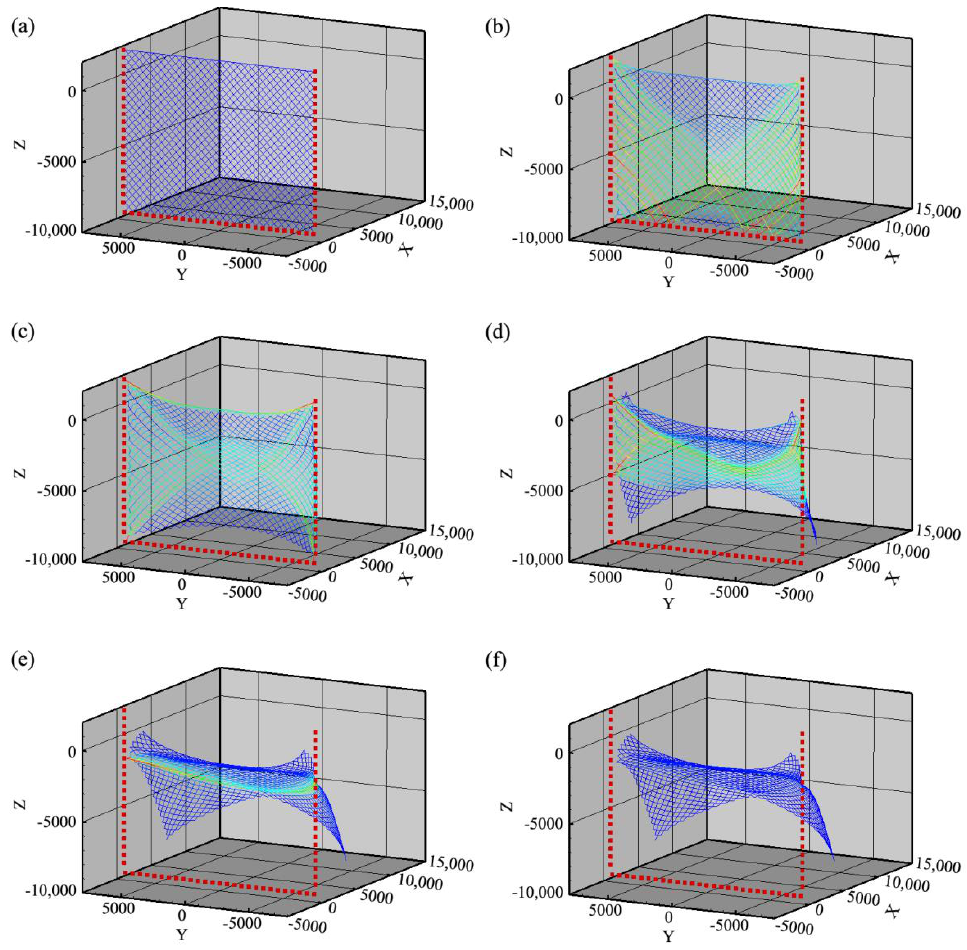
Figure 15. ( a – f ) Damage process of the mooring system for the trash-blocking nets when T m = 3.0 kN. When the strength of mooring lines ( T m ) is 3.0 kN, the bottom mooring lines break first, and then the side mooring lines start to break. When the strength of mooring lines ( T m ) is 4.0 kN, the top part of the side mooring lines breaks first, and then all of the side mooring lines are broken; finally, the fracture of the bottom mooring lines occurs. In general, the whole mooring system can be destroyed when one mooring line starts to break, and the damage mode of mooring lines is determined by the strength of mooring lines.